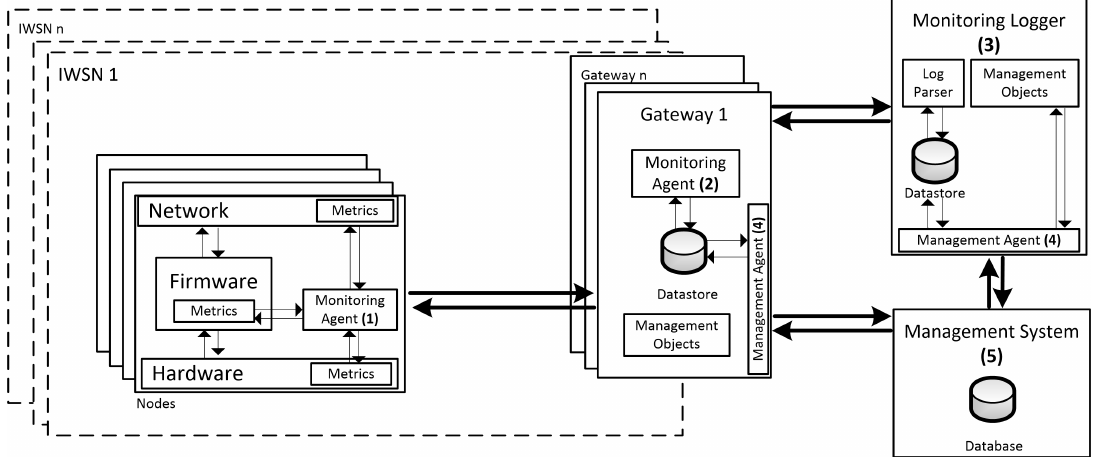
Figure 1. Proposed monitoring